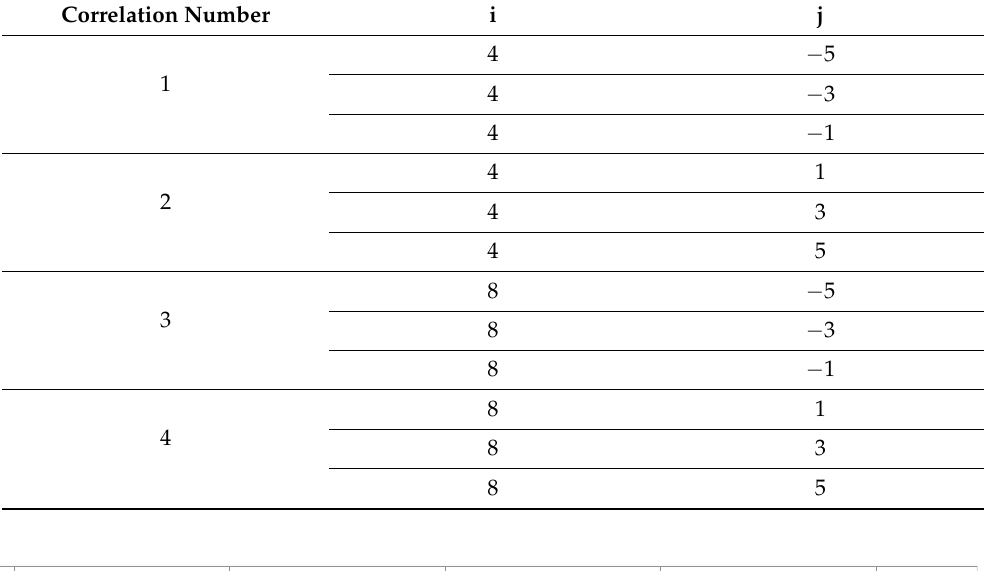
Table A2. List of spectral components, used for outer race diagnosis.